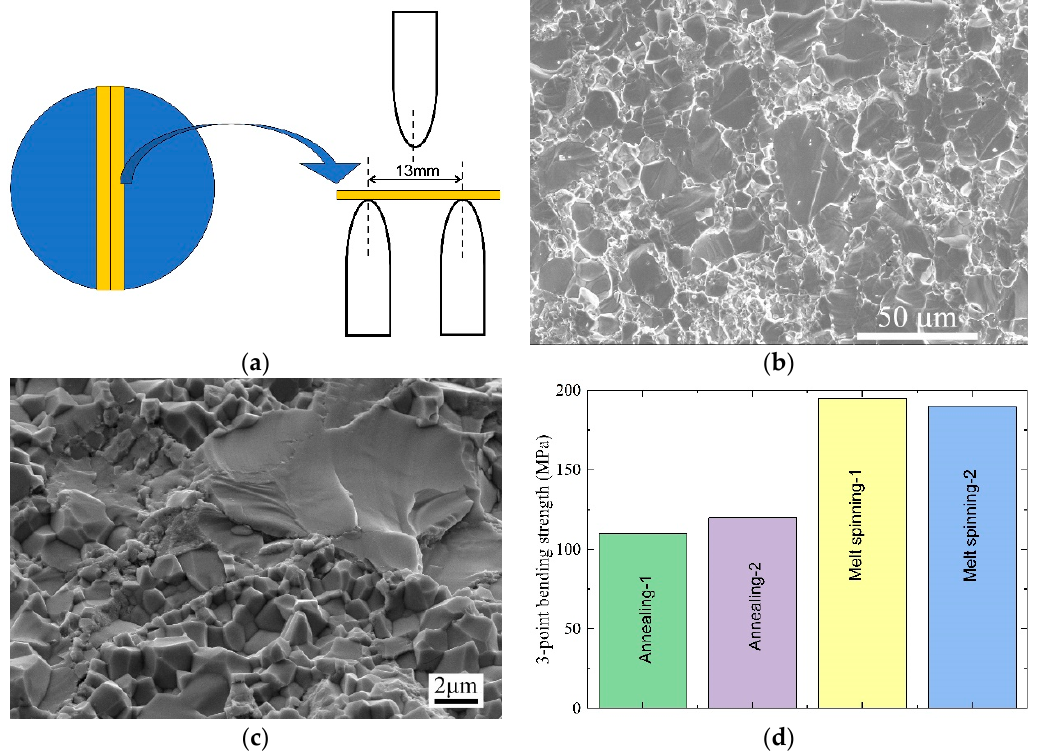
Figure 8. ( a ) The schematic representation of the three-point bending strength measurement set up. ( b ) The fracture microstructure of the annealed sample represented a typical transgranular fracture. ( c ) The fracture microstructure of the melt spinning sample represented a typical intergranular fracture. ( d ) The three-point bending strength. The grain-boundary strengthening greatly improved the three-point bending strength of the melt-spinning samples.